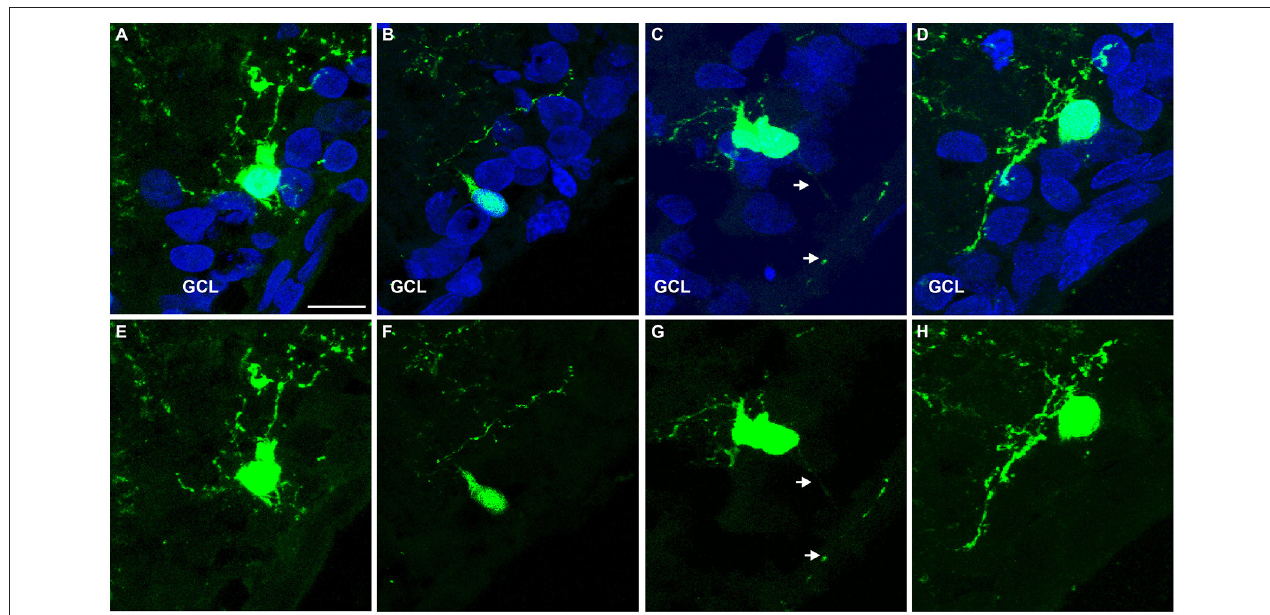
FIGURE 8 | Representative examples of GFP + cells within the GCL of Neurog2-electroporated retinas. (A–H) Images show GFP + cells (green) within the GCL of P10 rats after electroporation with Neurog2-I-GFP at P0. Nuclei are stained with DAPI (blue, A–D ). Note the distinct positions and dendrite stratifications of GFP + cells (E-H) , resembling bona fide subtypes of rodent RGCs ( Sanes and Masland, 2015). Scale bar: 25 µ